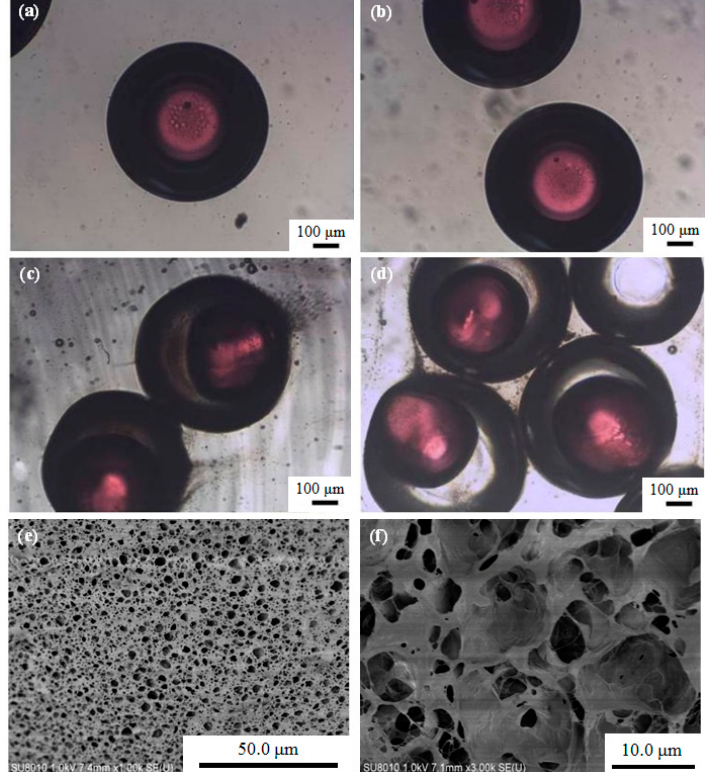
Figure 3. ( a – b ) Optical microscopy photographs of O/W/O emulsion droplets, ( c – d ) optical Figure 3. ( a , b ) Optical microscopy photographs of O / W / O emulsion droplets, ( c , d ) optical microscopy photographs of P(NIPA- co -MAA) microcapsules in collection solution, and ( e ) SEM image of the surface morphology of P(NIPA- co -MAA) shells. ( f ) SEM image of the internal morphology of P(NIPA- co -MAA) shells. The MAA content of the sample is 3